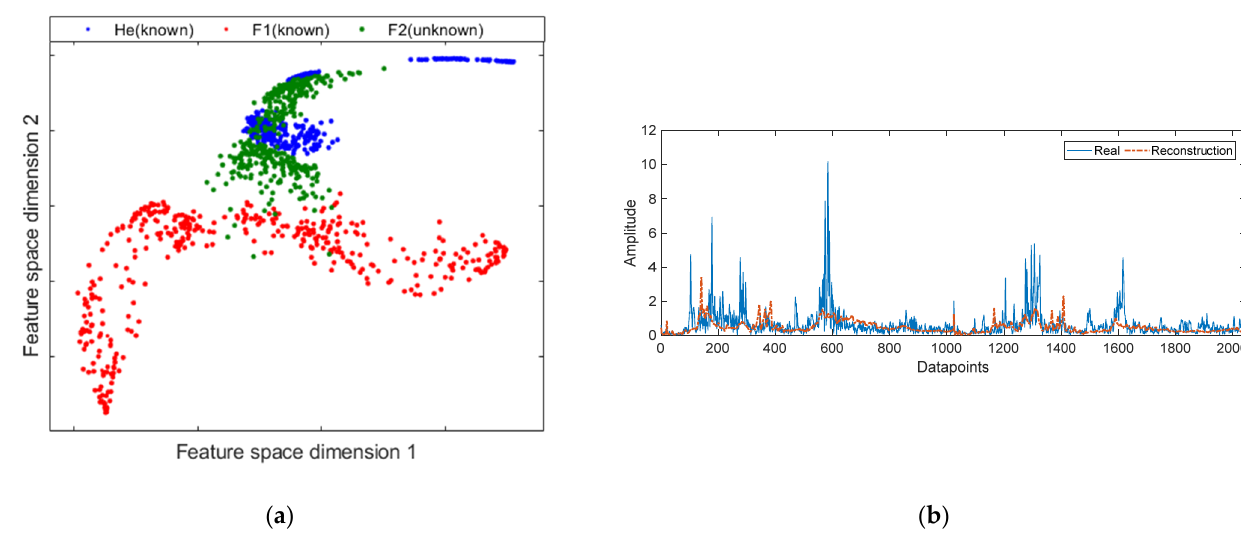
Figure 6. Characterization of known states (He and F1) and an unknown fault state (F2): ( a ) feature space mapping of the bottleneck obtained through a traditional DAE; ( b ) real signal of unknown fault status and its respective reconstruction by mean DAE.